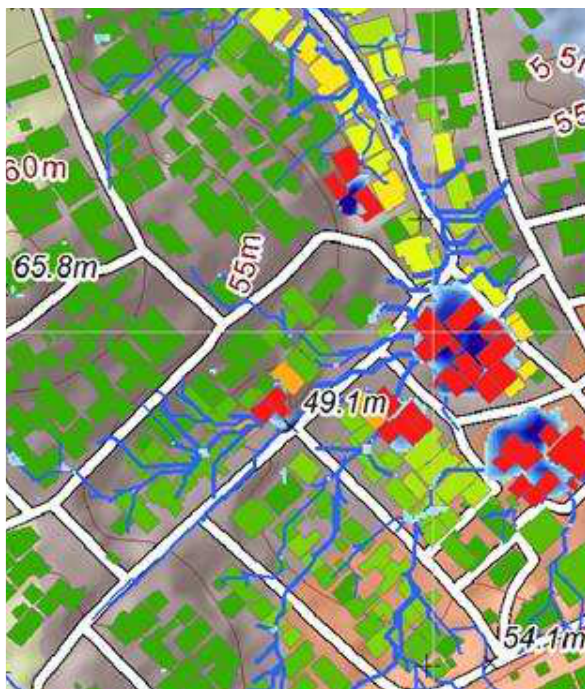
Figure 3 – Water runoff risk assessment showing the water paths and the building